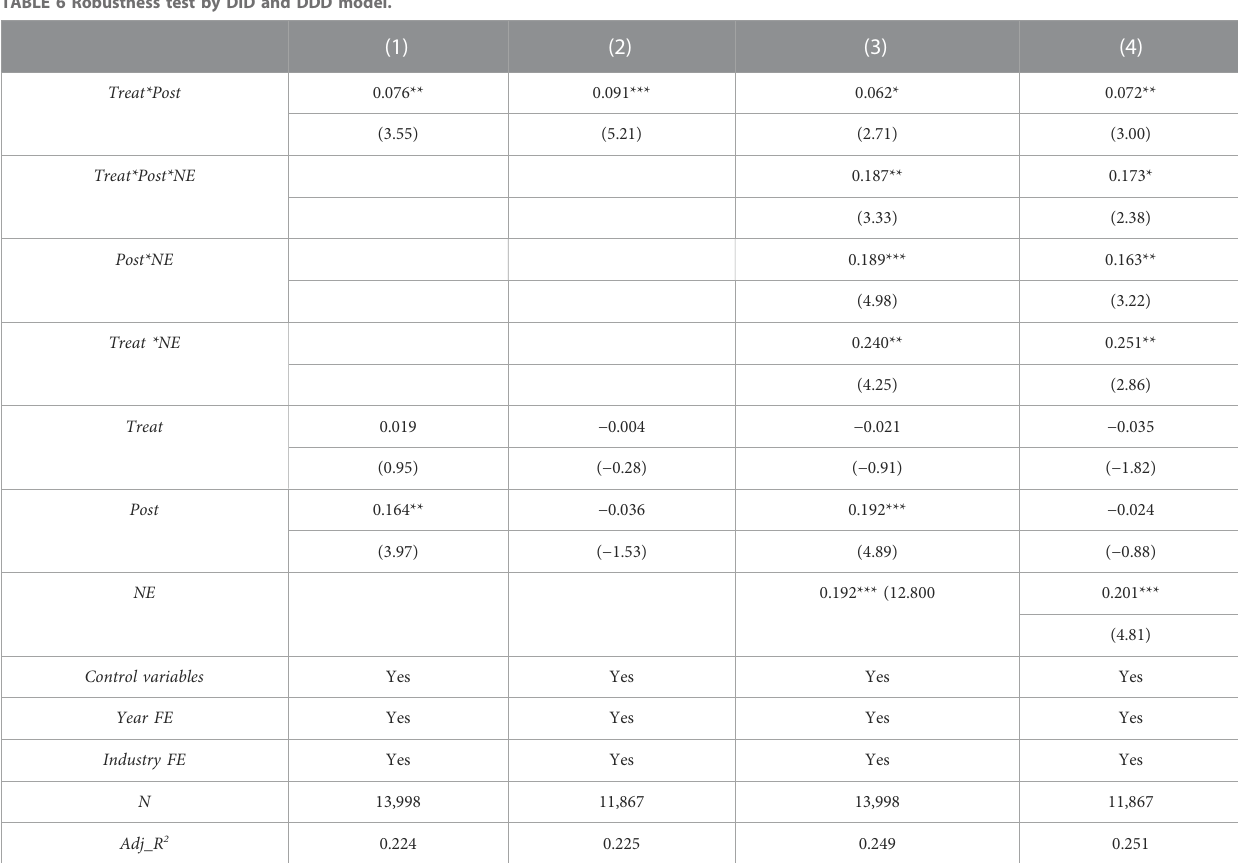
TABLE 6 Robustness test by DID and DDD